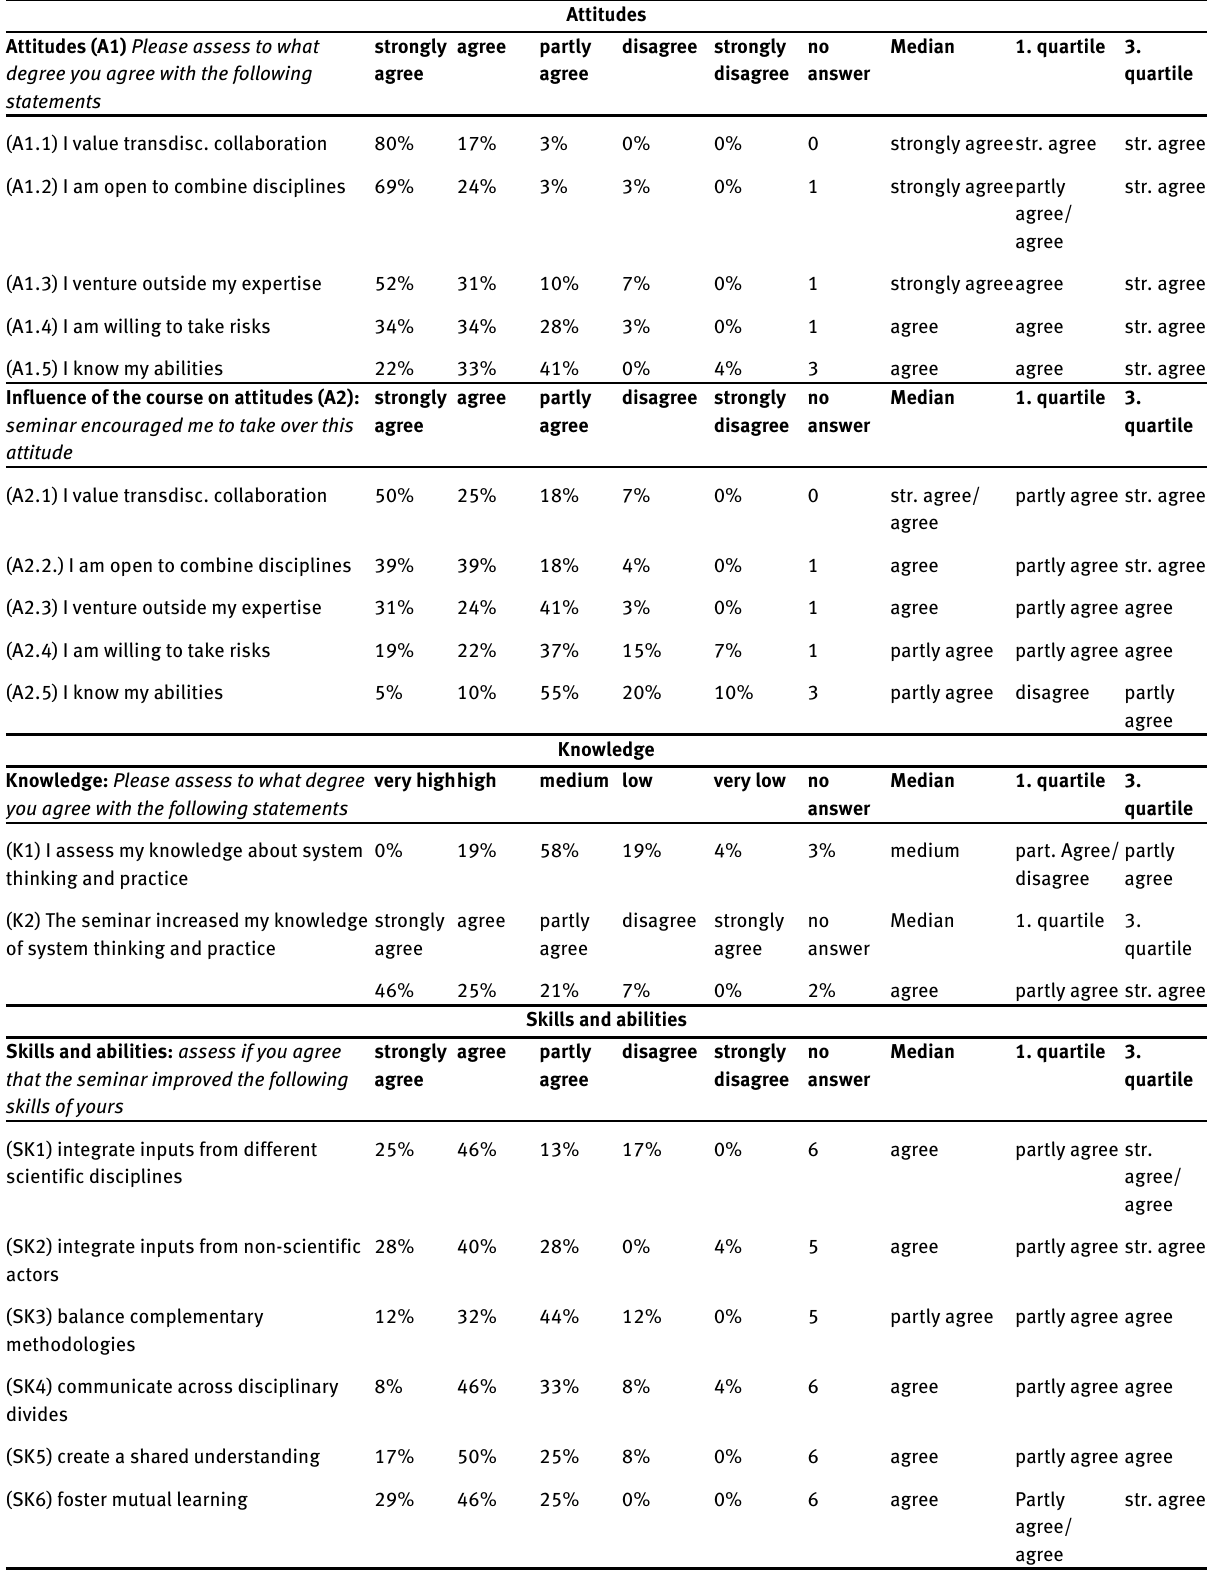
Table 3: Transdisciplinary